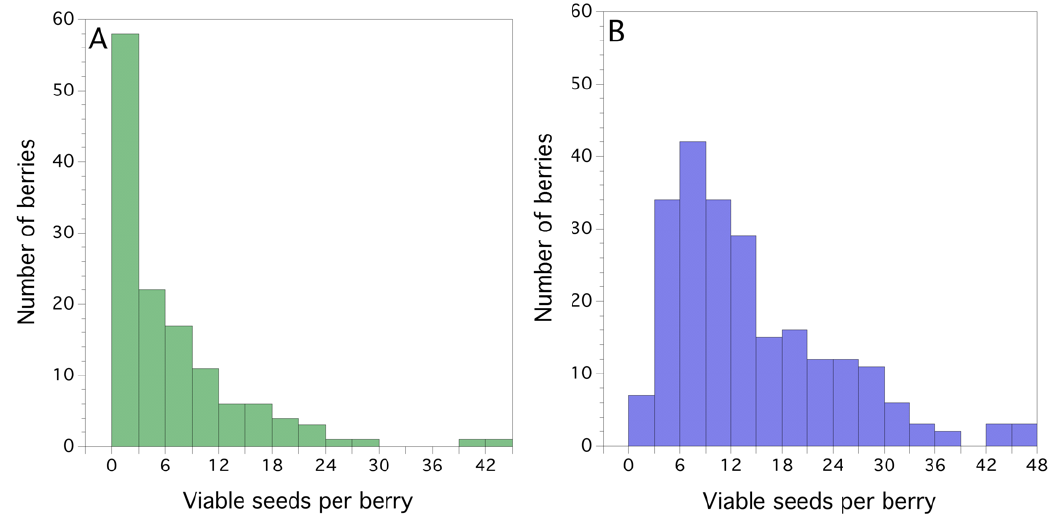
Figure 5. Frequency distributions of viable seeds/berry in eastern Maine, USA: ( A ) dropped fruit and ( B ) harvested fruit, collected in a commercial wild blueberry field in 2011.